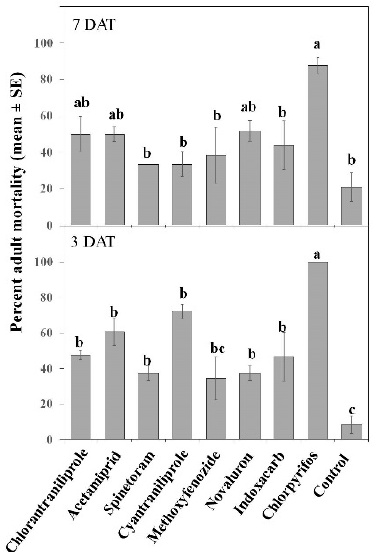
Figure 9. Effect of various insecticides on Orius insidiosus adults after exposure to 3 and 7 DAT field- aged residues. Bars with the same letter are not significantly different at α = 0.05.